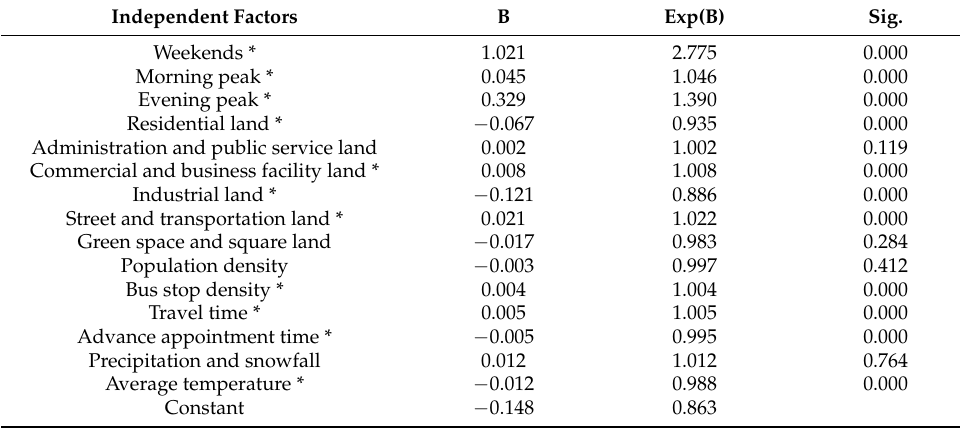
Table 2. Independent factor results of the Yinchuan model.